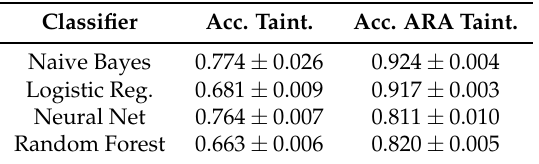
Table 2. Accuracy comparison (with precision) of four classifiers on attacked data, with and without ARA-enhanced defence.